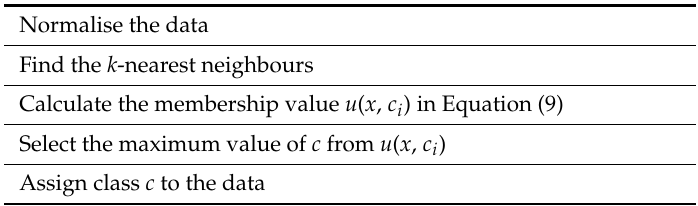
Table 3. Pseudocode for executing the Fuzzy k -NN algorithm [22,23].